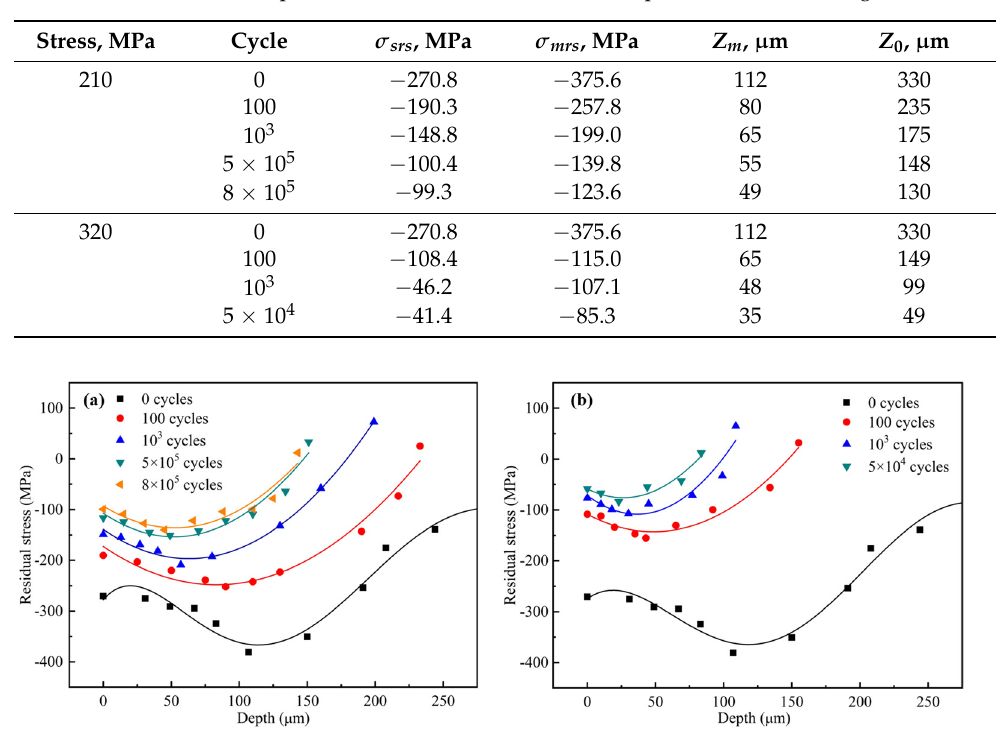
Table 1. RSF characteristic parameters under different stress amplitudes in tensile fatigue tests.